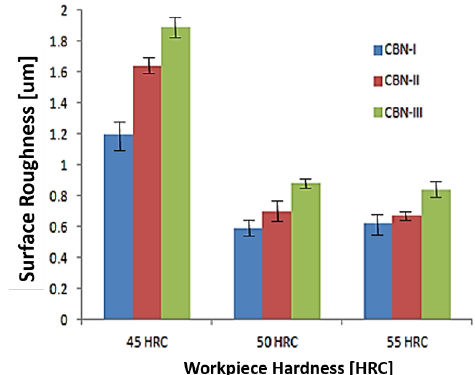
Figure 5. Comparisons of Surface roughness obtained with different CBN insert corresponding to workpiece hardness.